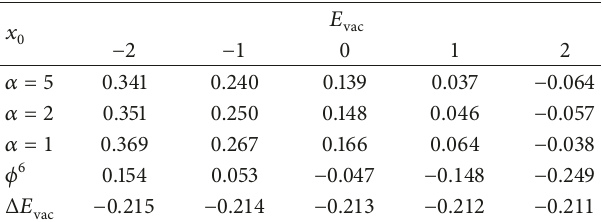
Table 4: The VPE as a function of the position of the center of the potential for 𝑉 훼 and the 𝜙 6 model soliton. Δ𝐸 vac is the difference between the VPEs of the latter and 𝑉 1